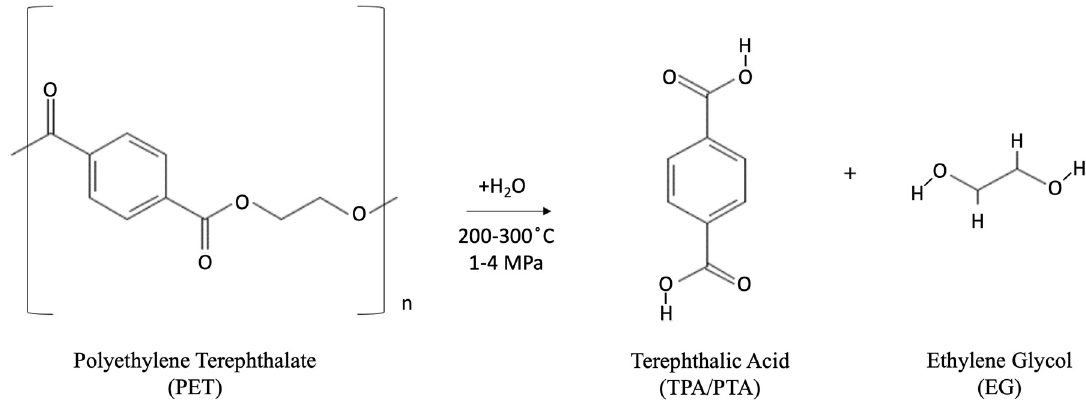
Figure 8. Chemical reaction during neutral hydrolysis process.